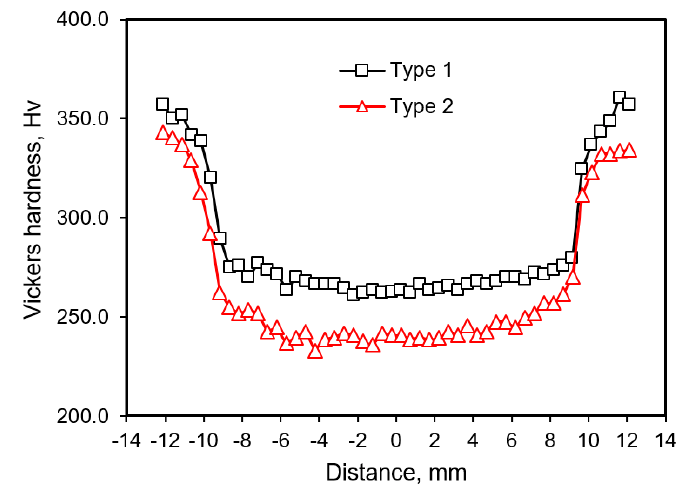
Figure 13. Variation of microhardness obtained from TPS for Cases 1 and 2.